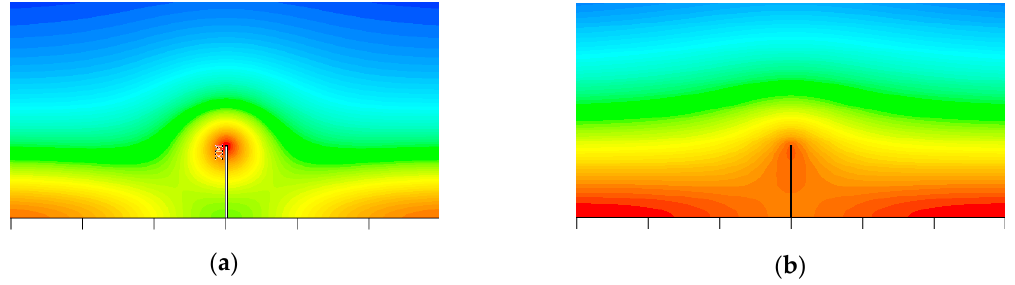
Figure 20. ( a ) Temperature distribution after 0.1 s and ( b ) 1 s heating pulses for the same scenario as shown in Figure 18.